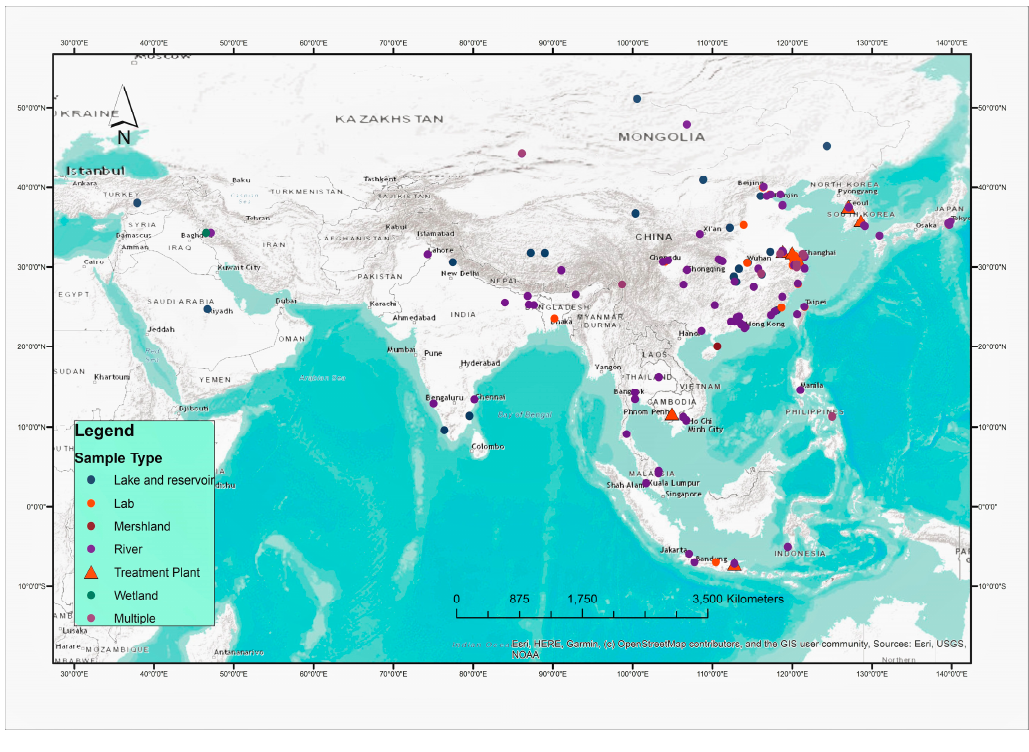
Figure 3. Map of study locations of reviewed articles.